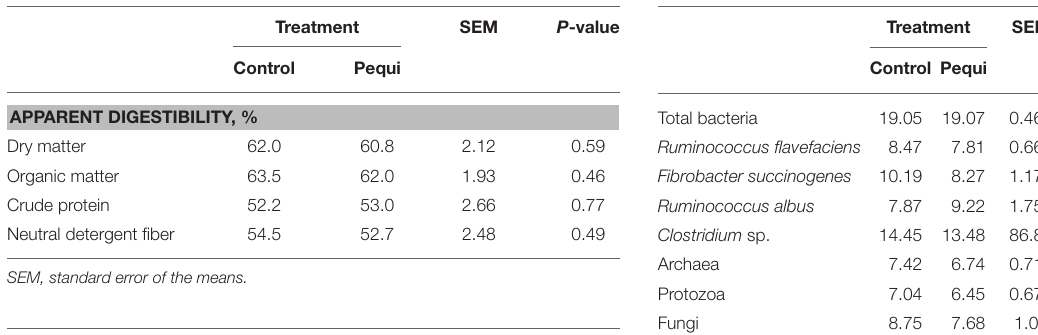
TABLE 7 | Effect of pequi oil on dry matter intake (DMI), methane production and heat production in wethers fed a hay-based diet.